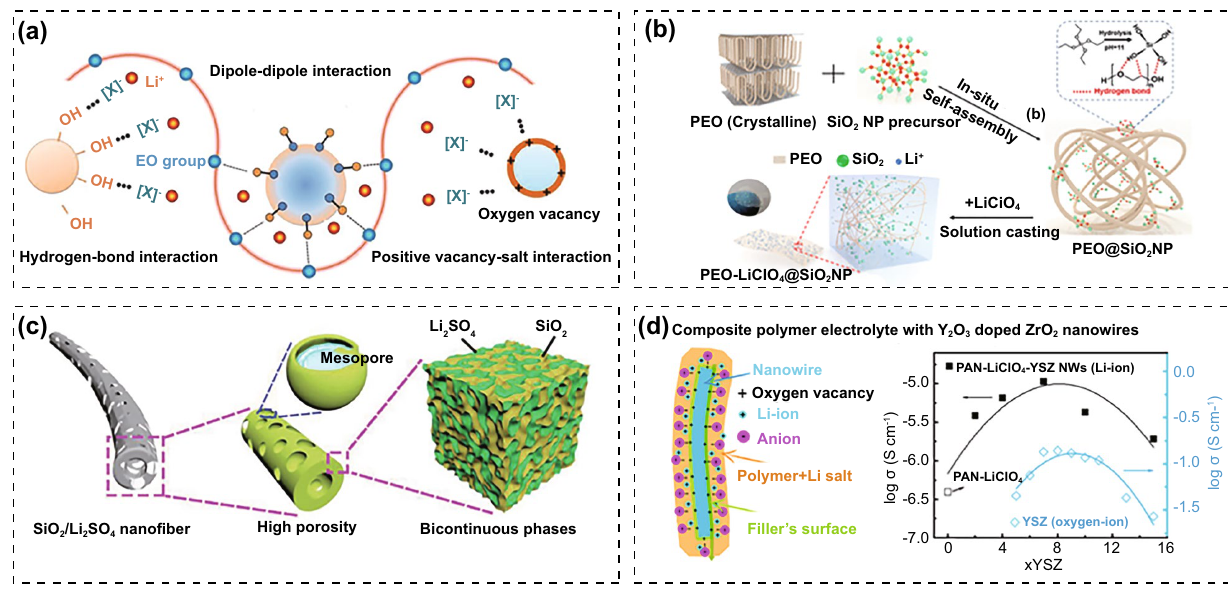
Fig. 6 a Lewis acid–base interaction between different components in PIEs [32]. Copyright 2019, John Wiley and Sons Publisher. b Synthetic process of the